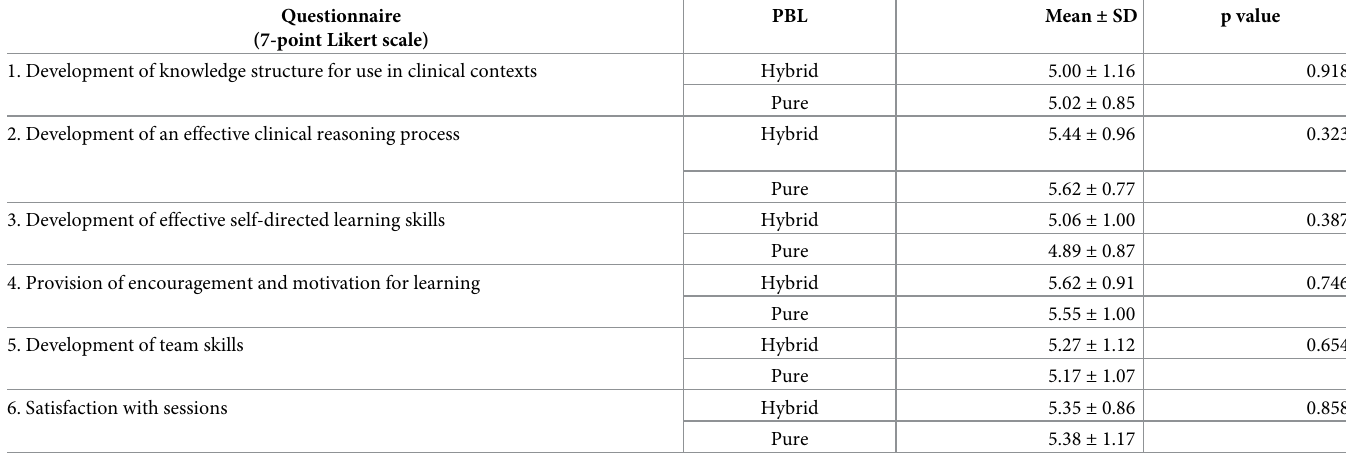
Table 3. Fifth-year medical students’ perceived competence in PBL and satisfaction with sessions after educational intervention, about hybrid- and pure -PBL, Chiba University Hospital (N = 99). Questionnaire (7-point Likert